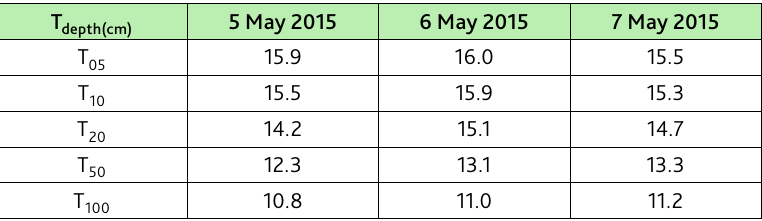
Table 3. Soil temperature [°C] at the reference station Olomouc-Holice on